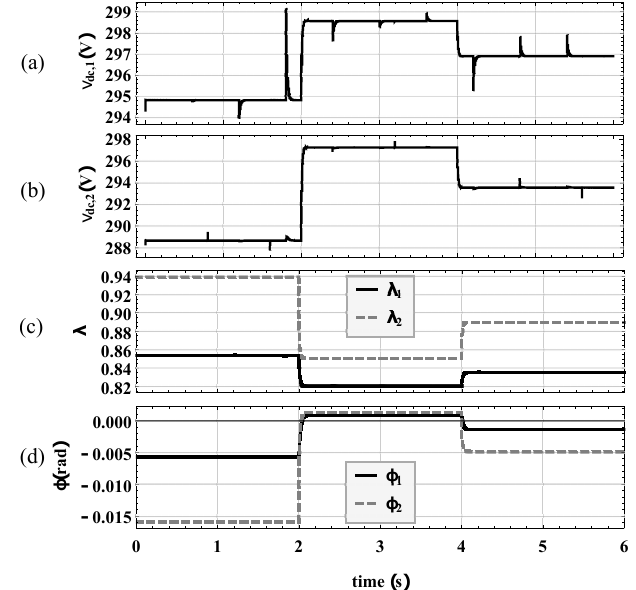
Figure 19. Source and ESS dc power contributions for ( a ) DGU 1 and ( b ) DGU 2 .